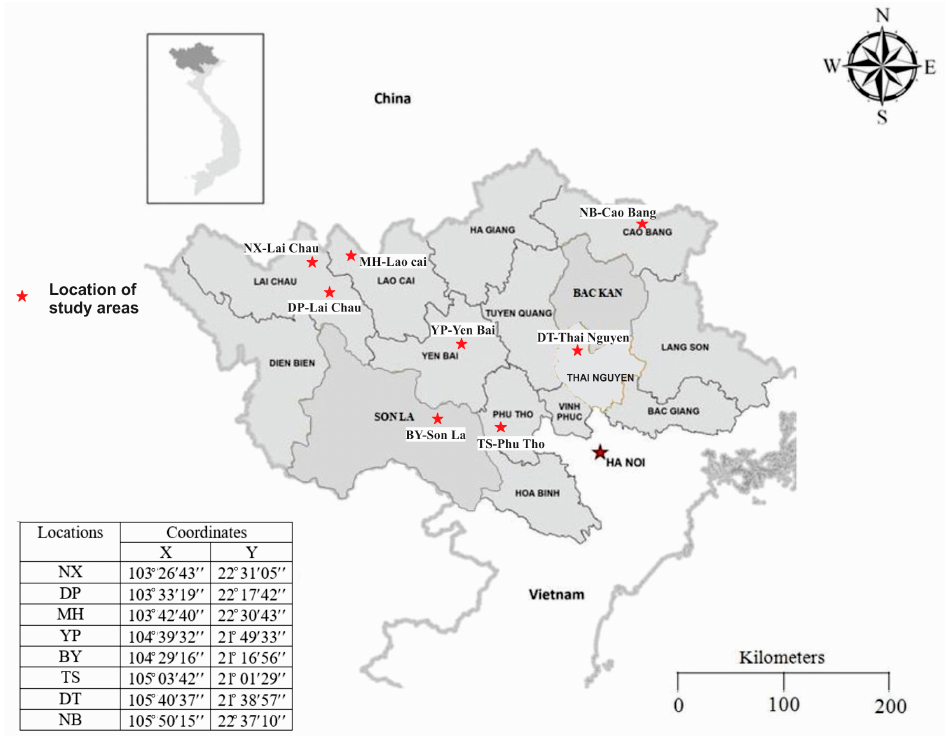
Figure 1. Location of the study areas (map was modified from Hung et al., 2016) [18].